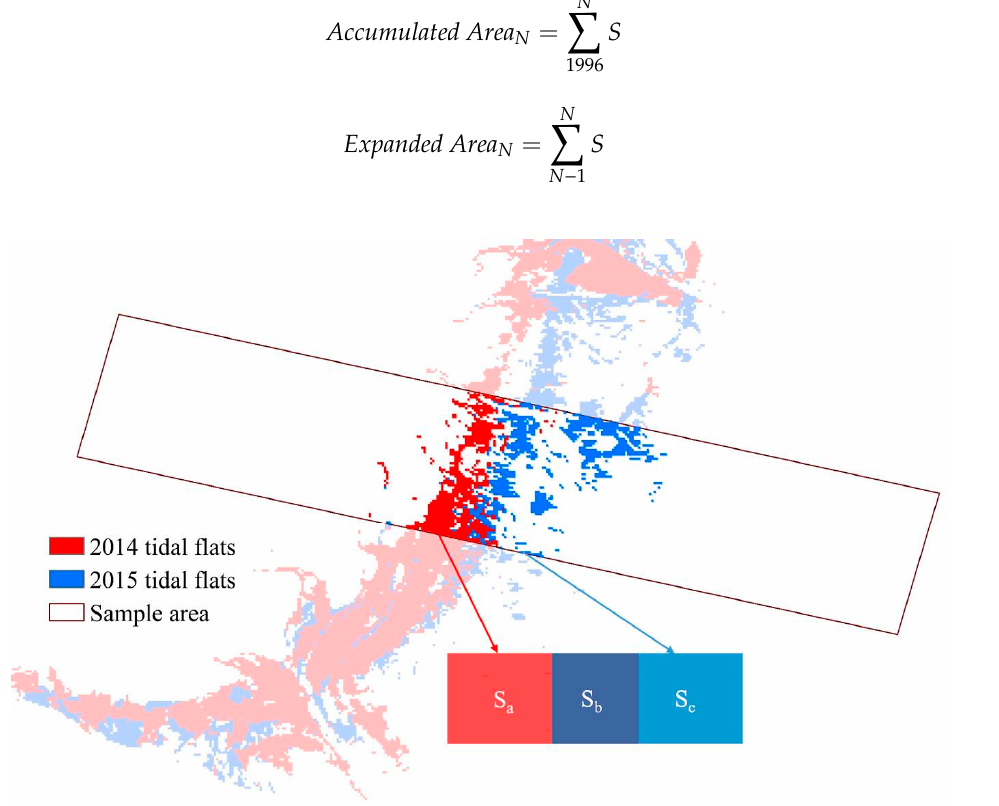
Figure 5. Computational method of overlapping sample area. For single sample area of Year N and Year N + 1 : red (S a + S b ): tidal flats area of Year N ; blue (S b + S c ): tidal flats area of Year N + 1 ; dark blue (S b ): overlapping area of Year N and Year N + 1 ; S a + S b + S c : accumulated area of Year N and Year N + 1 ; S c : expanded area of Year N + 1 .